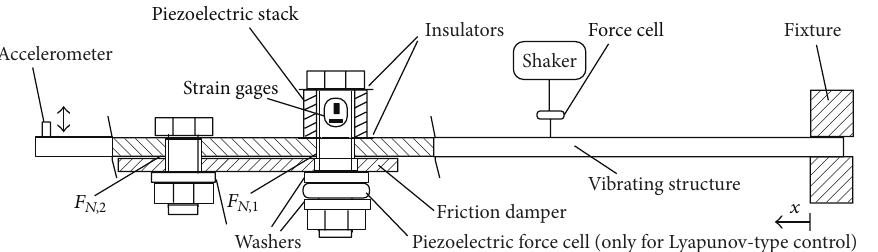
Figure 1: Sketch of the benchmark structure (steel, 775 mm length, 40 mm width, and 3 mm thickness) with adaptive friction damper beam (steel, 160 mm length, 40mm width, and 3mm thickness).